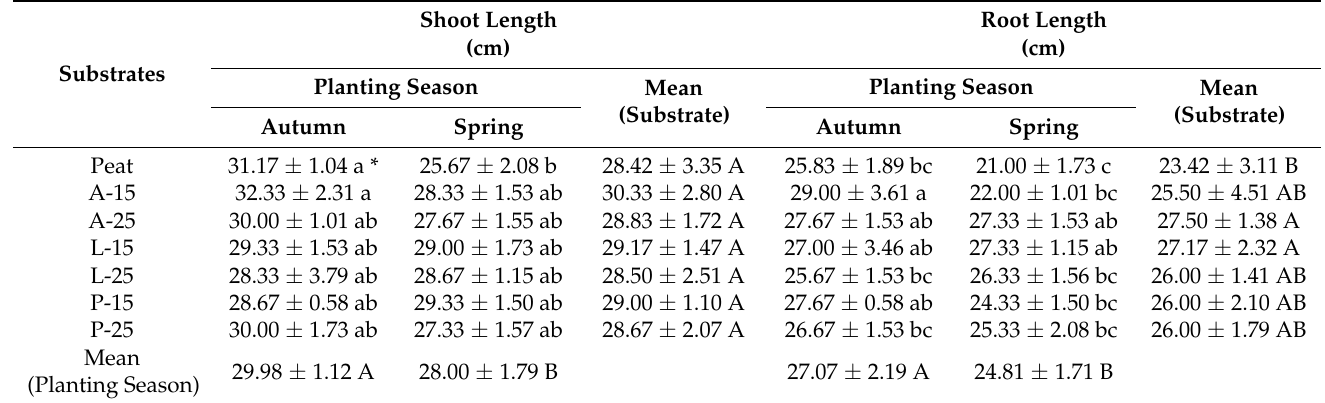
Table 7. Strawberry morphological parameters as influenced by substrates and planting